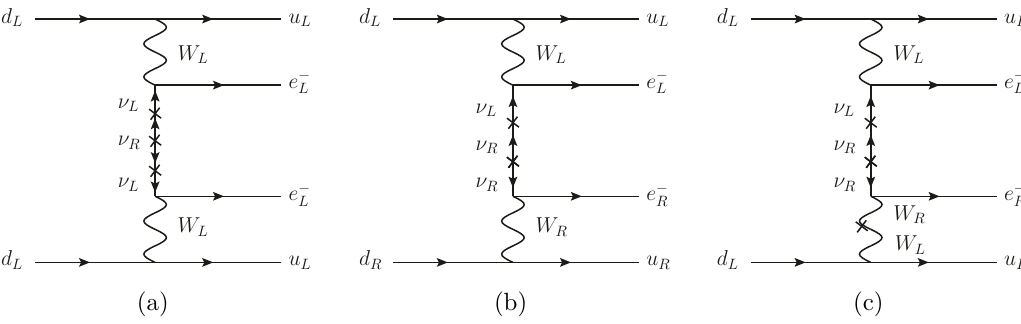
Figure 5. Contributions to the 0 νββ decay due to a non-vanishing Dirac mass term M D . The cross vertices ( × ) in between ν and Dirac mass terms, and the left-right mixing,